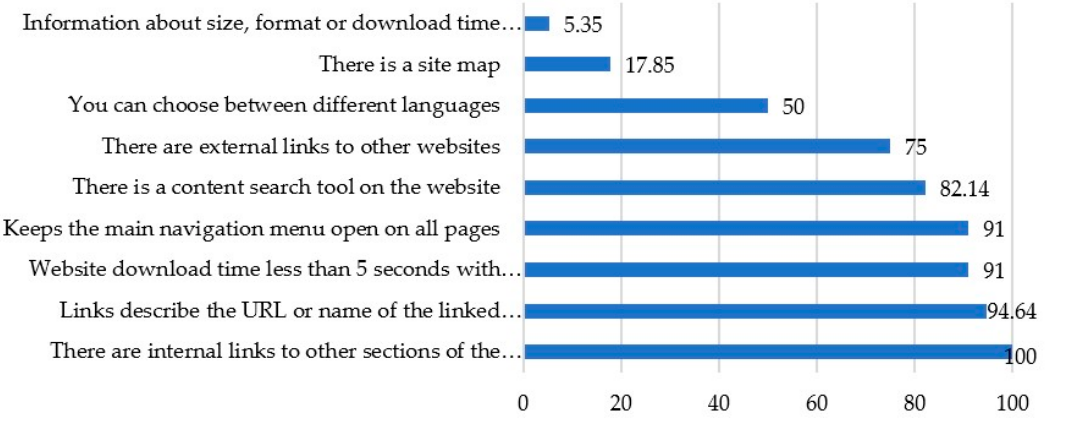
Figure 2. Representing “Usability” scores in percentages for all hospitals from the sample.